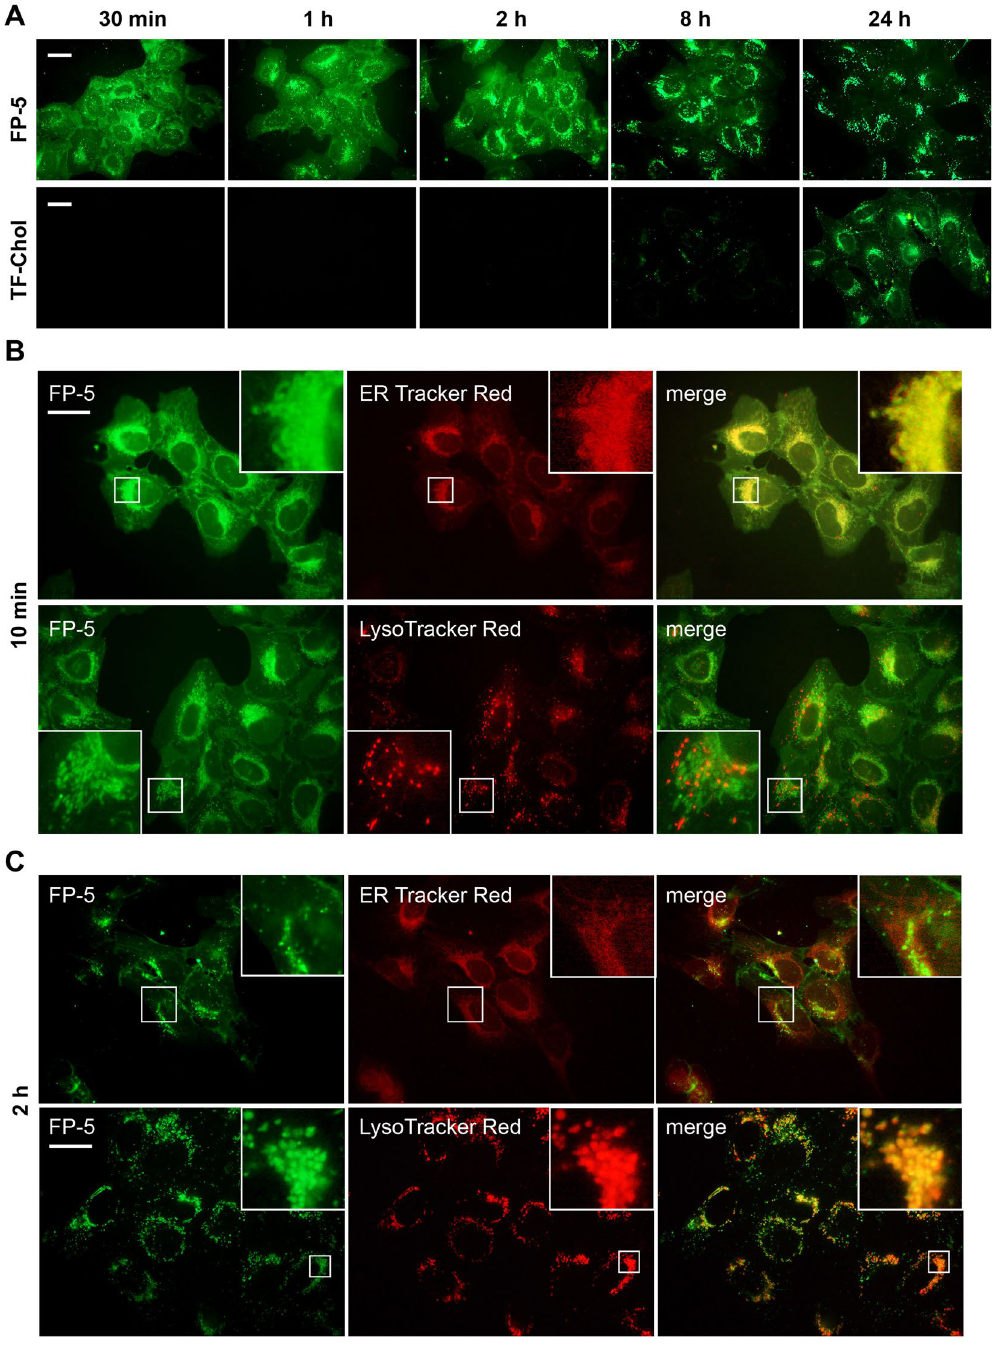
Figure 3. The kinetics and localization of intracellular fluorescence of FP-5 and TF-Chol in U-2 OS cells. ( A ) Probes in DMSO solution were directly added to cultivation medium with 10% FCS at final concentration 0.5 μ M and live fluorescence was recorded at indicated time points. Scale bar represents 10 μ M. ( B , C ) Co- localization of FP-5 and organelle specific probes. Cells exposed to pulse with complex FP-5/M β CD (1 μ g/ml) were chased for 10 min or 2 h, co-labelled with ER Tracker Red or LysoTracker Red and examined. Expansions of the regions indicated by the white boxes are shown on the upper right side or low left side. Localization of TF- Chol is included in Supplementary Fig.